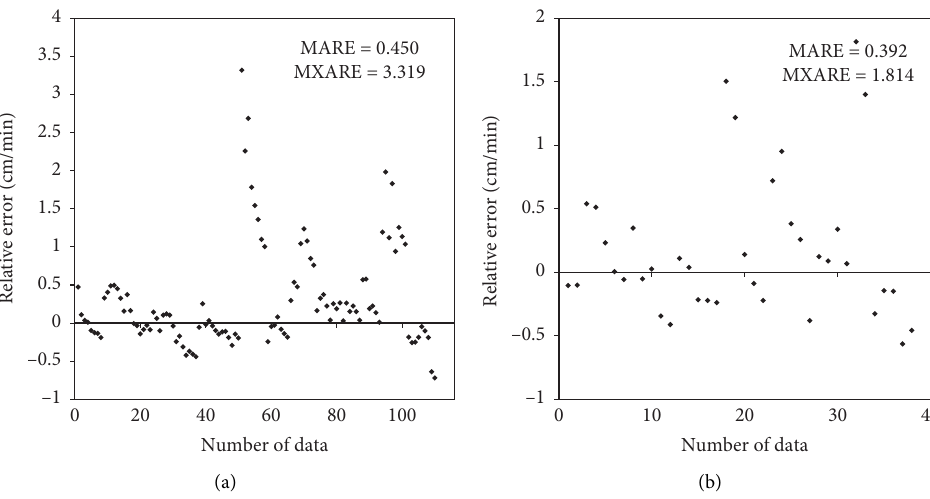
MARE = 0.450 MXARE = 3.319